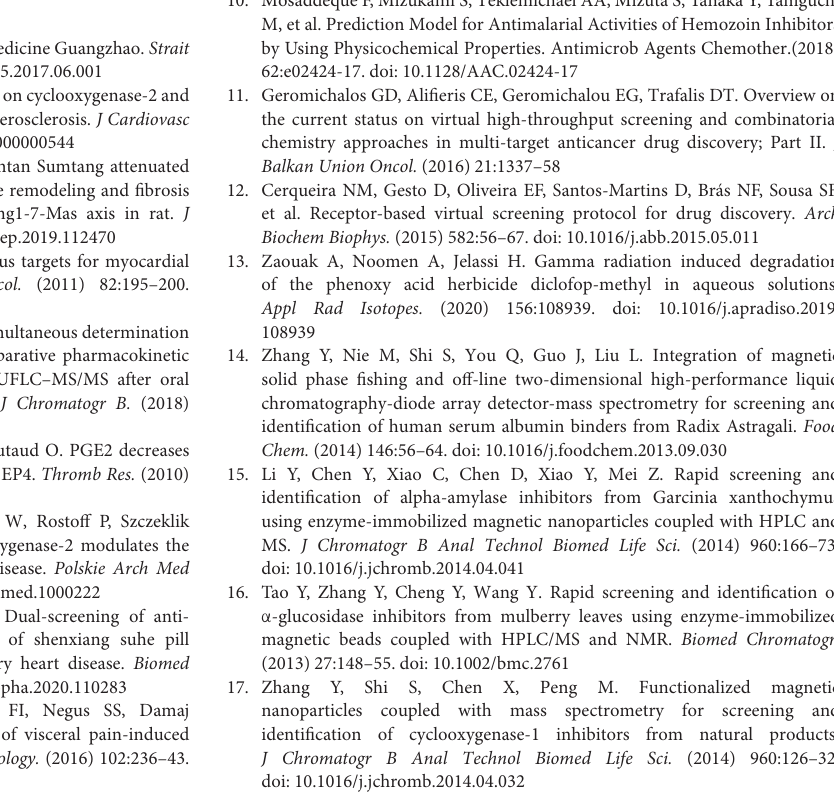
Supplementary Figure S1 | The HPLC chromatograms of celecoxib (a) and ligand fishing assay eluent by SMGO-COX-2 (b), MGO (c), SMGO-inactive COX-2 (d), and SMGO (e). Supplementary Figure S2 | The HPLC chromatograms of celecoxib in five consecutive association-dissociation cycles of ligand fishing assay eluent by